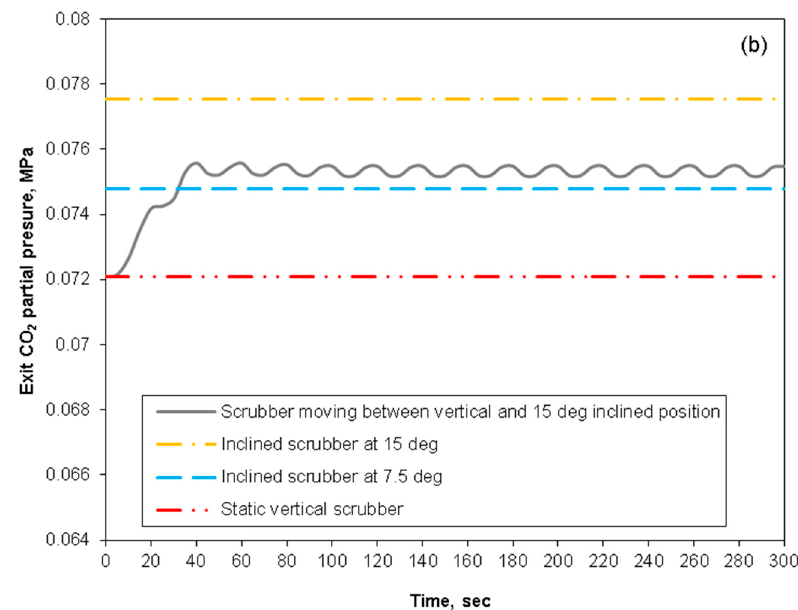
Figure 21. Time-dependent exit NO ( a ) and CO 2 ( b ) partial pressure in a seawater scrubber under angular sinusoidal oscillatory motion between the vertical and an inclined (15°) position (Packed-bed column with Raschig super-Rings; H = 5 m; Pressure = 1.5 MPa; Travel time between the vertical/inclined and inclined/vertical positions = 10 s).